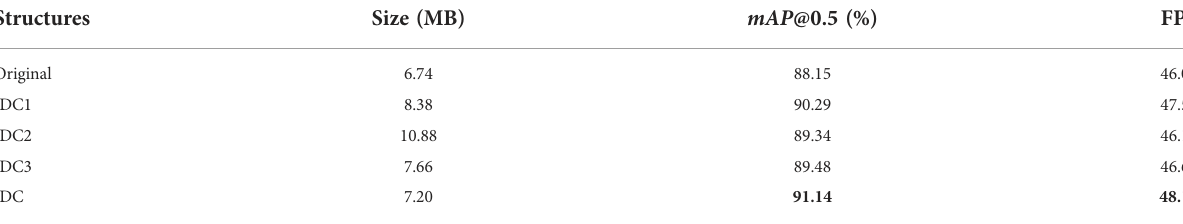
TABLE 2 Results of training with various JDC